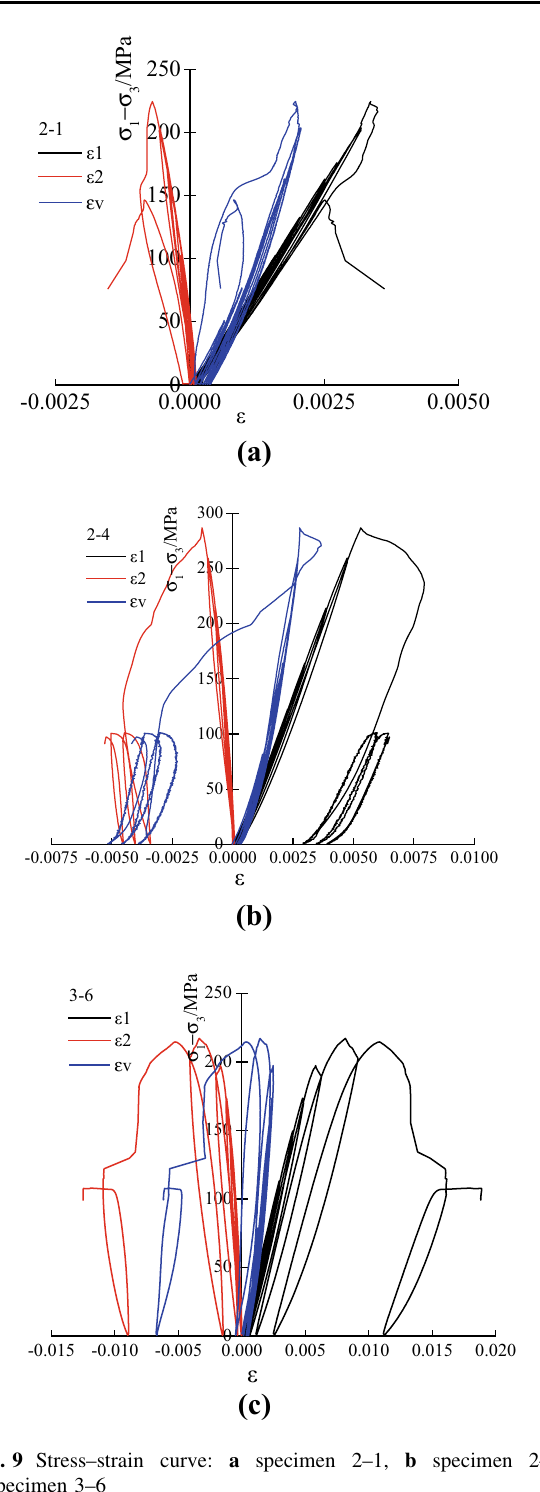
Fig. 9 Stress–strain curve: a specimen 2–1, b specimen 2–4, c specimen 3–6